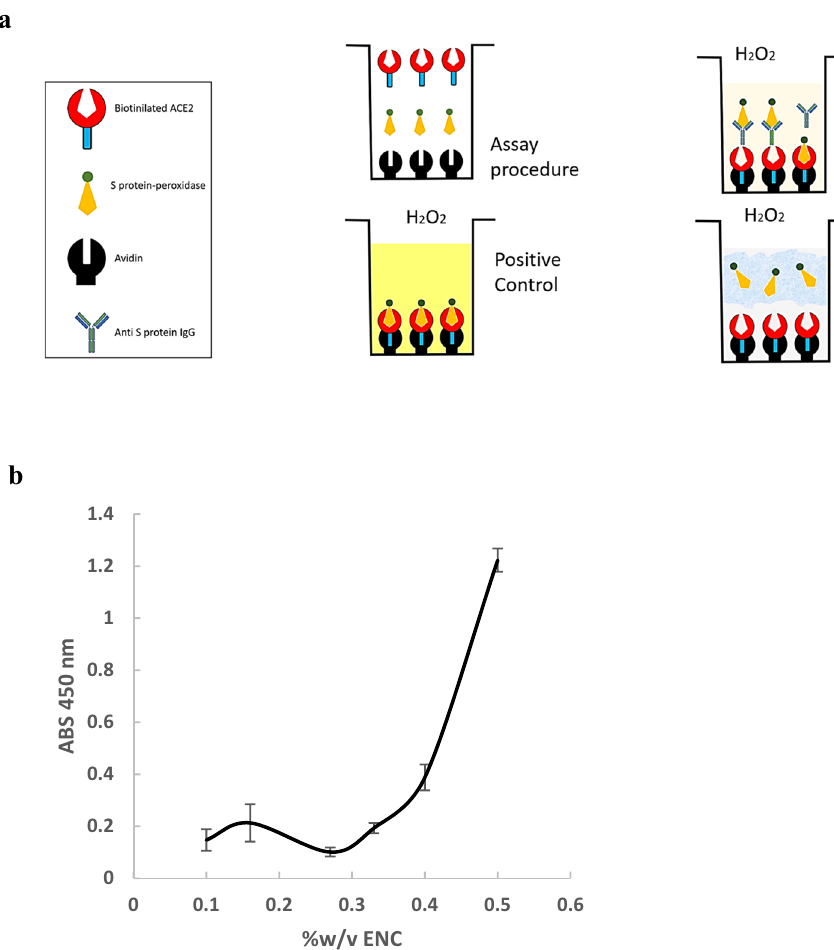
Figure 1. ELISA experiments of S-protein encapsulation vs anti S IgG docking. A modified ELISA protocol was used to demonstrate that SARS-CoV-2 S protein can be entrapped in endospermic nanocellulose (ENC) thus preventing its binding to ACE2. ( a ) Schematic of the modified ELISA protocol for encapsulation of S protein. The assay was modified to measure the ability of ENC to block the interaction of S protein with ACE2, rather than the ability of anti-S neutralizing antibody to block this interaction; ( b ) The modified ELISA was used to determine optimum % of ENC suspension (expressed in w/v) to efficiently encapsulate S protein; lower absorbance equals higher S protein encapsulation (n =